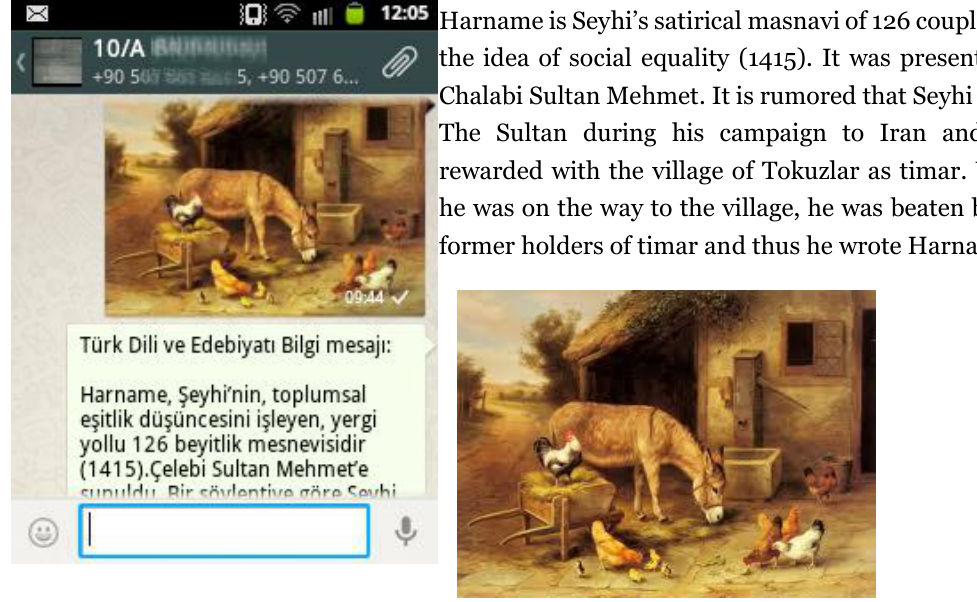
Figure 1. Information message